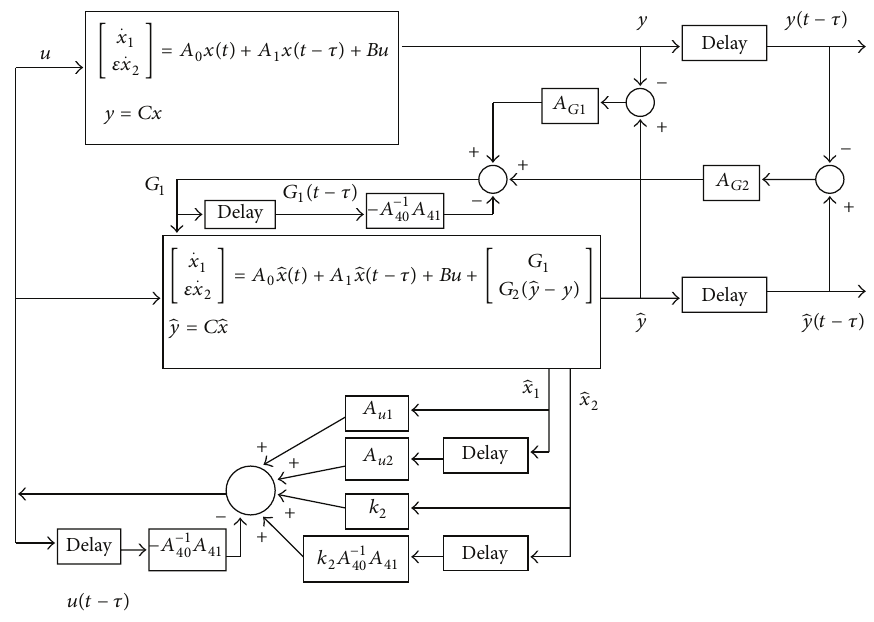
Figure 2: Block diagram for the controller and observer design of the systems